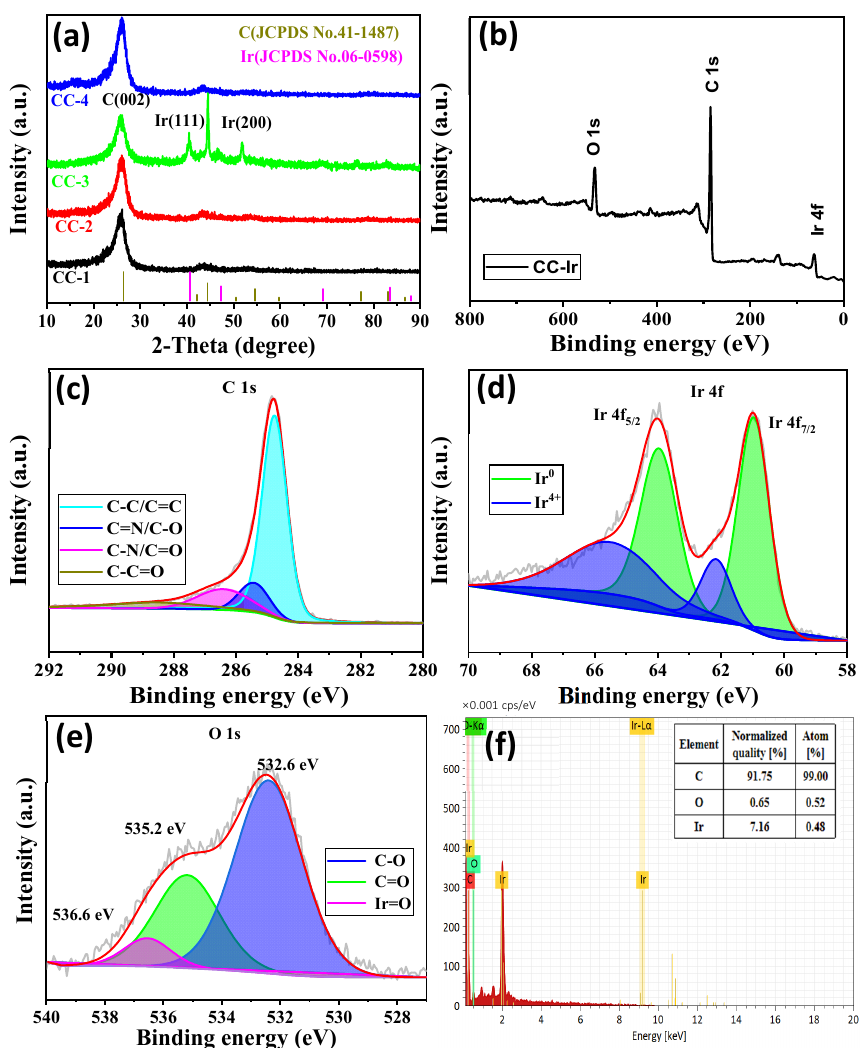
Figure 3. ( a ) XRD patterns of Ir catalysts obtained at different electroplating temperatures. ( b ) XPS surveys of CC-3. ( c – e ) C 1s, Ir 4f, and O 1s XPS spectra of CC-3, respectively. ( f ) EDS spectrum of CC-Ir.